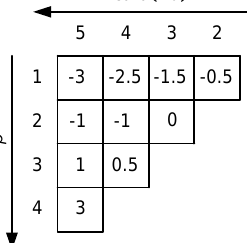
Figure 3. A triangle table dedicated at determining efficiency of mapping to configurable logic blocks LUT_5/1 or LUT_4/2.